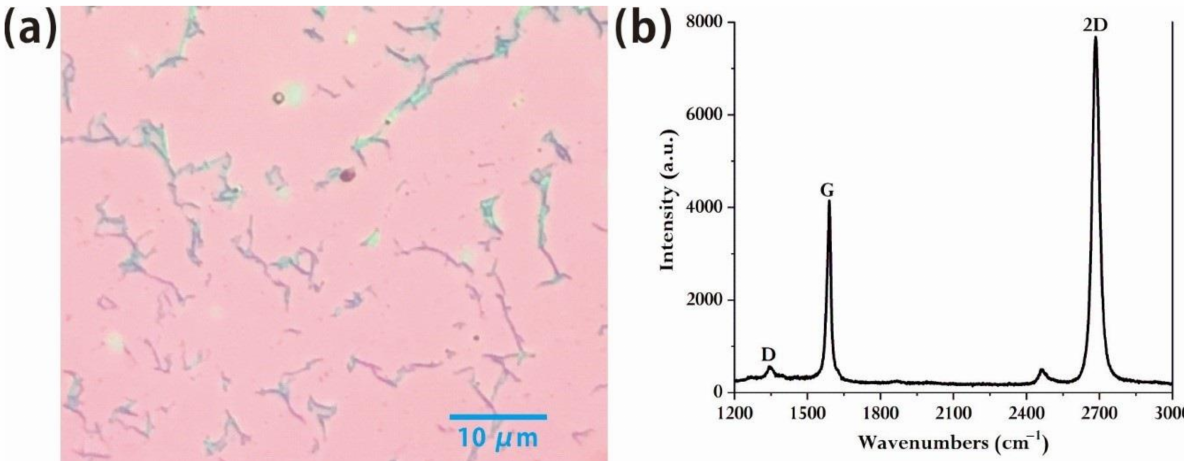
Figure 1. ( a ) Optical microscope diagram of graphene prepared by refined liquid benzene at high temperature of 1060 ◦ C with benzene partial pressure of 1.1 Pa; ( b ) corresponding Raman spectrum diagram of graphene in ( a